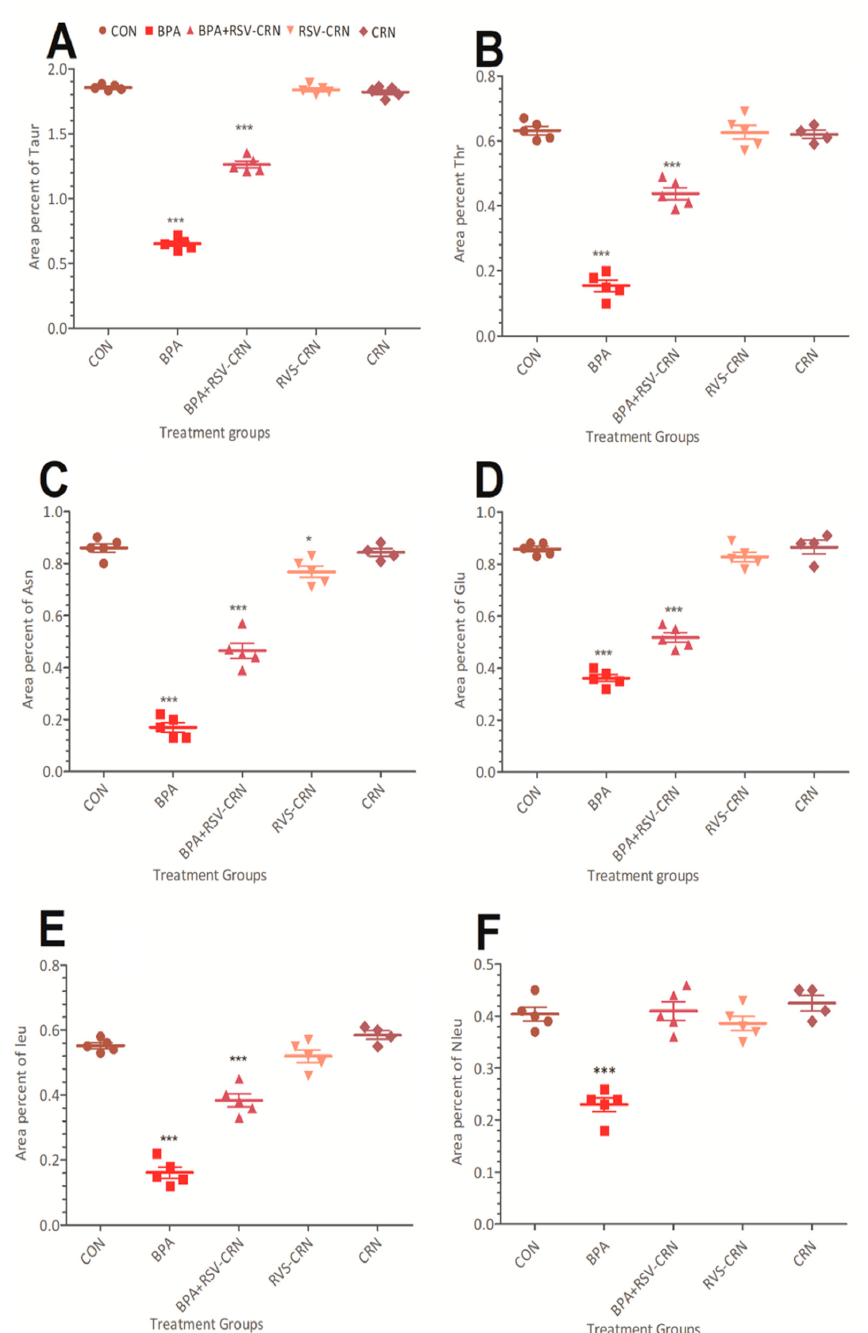
Figure 5. Graphical representation of the results of the amino acid analyzer: ( A ) taurine, ( B ) threonine, ( C ) asparagine, ( D ) glutamic acid, ( E ) leucine, and ( F ) norleucine in the plasma of different mice groups, i.e., CON, BPA, BPA+RSV-CRN, RSV-CRN, and CRN groups, respectively. The quantitative analysis was performed at the end of the experiment of 28 days using a one-way ANOVA followed by Tukey’s test to compare all pairs of columns. Each group contained 5 animals. The error bar represents the mean ± SD. * are used to illustrate the statistical significance of results where *** represents a highly significant difference in comparison to the control group while * shows a statistically low significance. Abbreviations: Taur: Taurine; Thr: Threonine; Asn: Asparagine; Leu: Leucine; Nleu: Norleucine; Glu: Glutamic acid; CON: Control group; BPA: BPA group; BPA+RSV-CRN: BPA and resveratrol blended in corn oil group; RSV-CRN: Resveratrol blended in corn oil group; CRN: Corn oil group; ANOVA: Analysis of